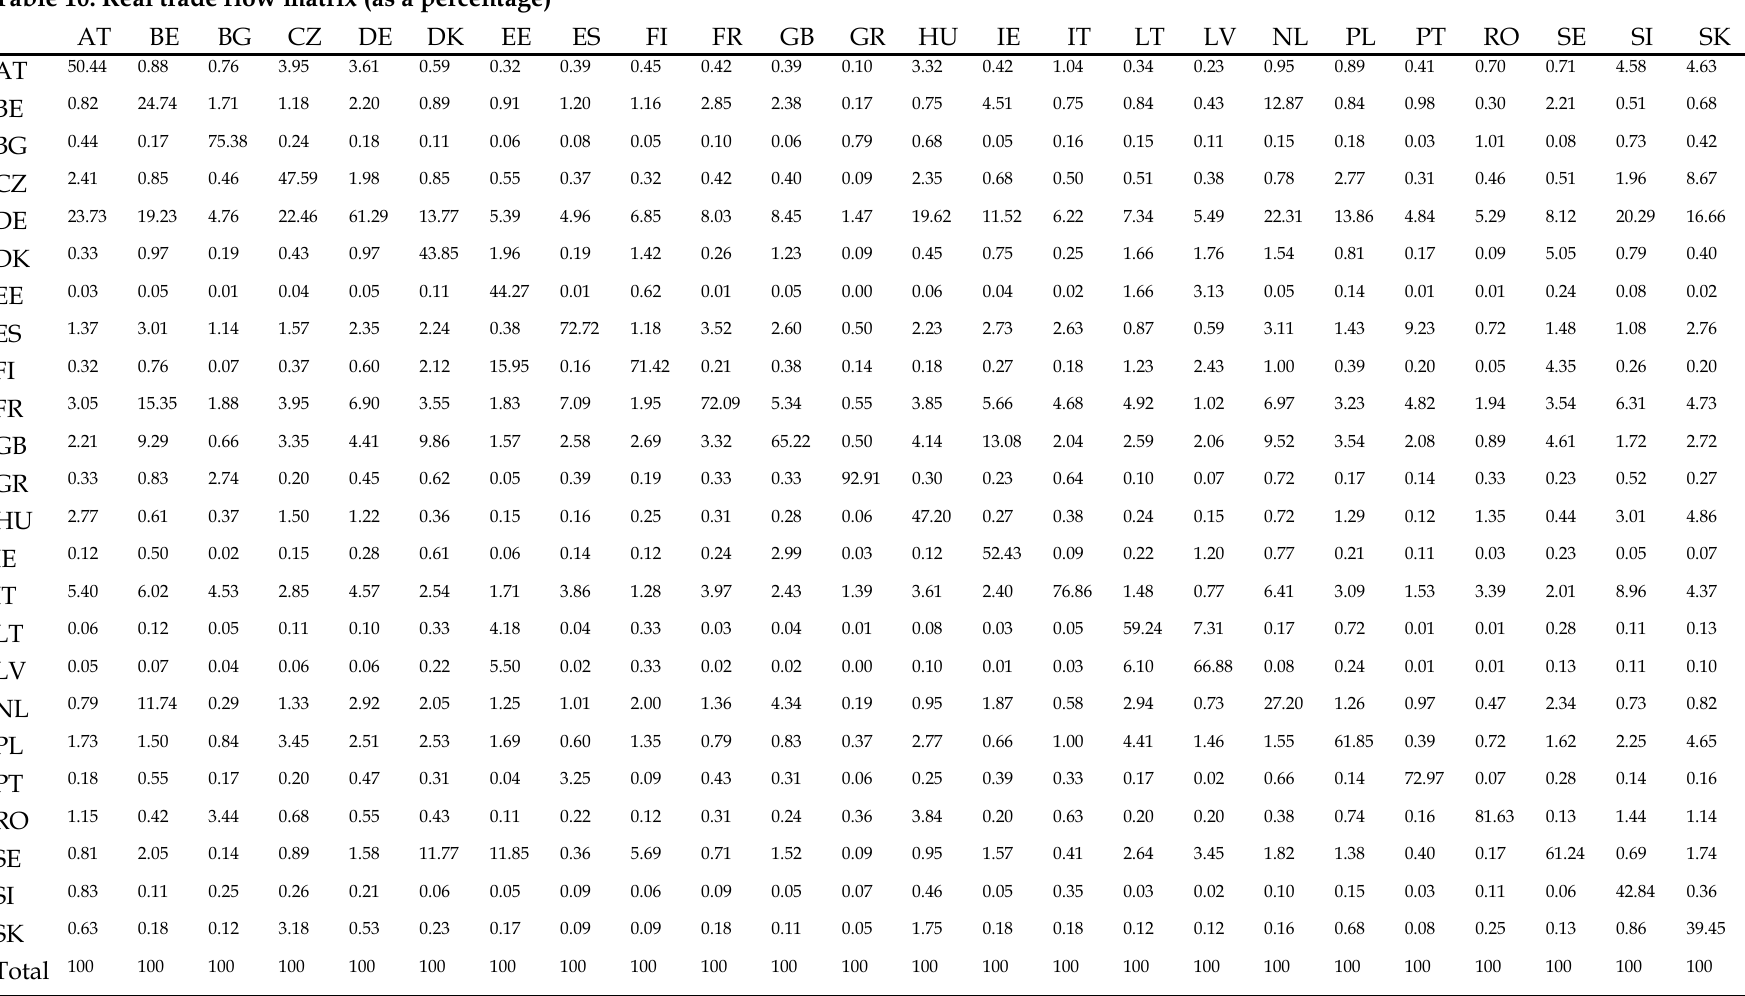
Table 10. Real trade flow matrix (as a percentage)